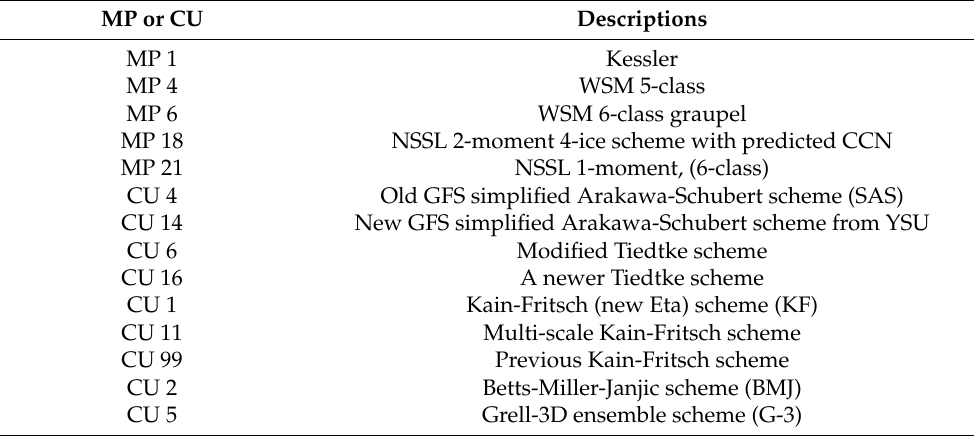
Table 1. WRF microphysics (MP) and cumulus (CU) parameterisations and descriptions.